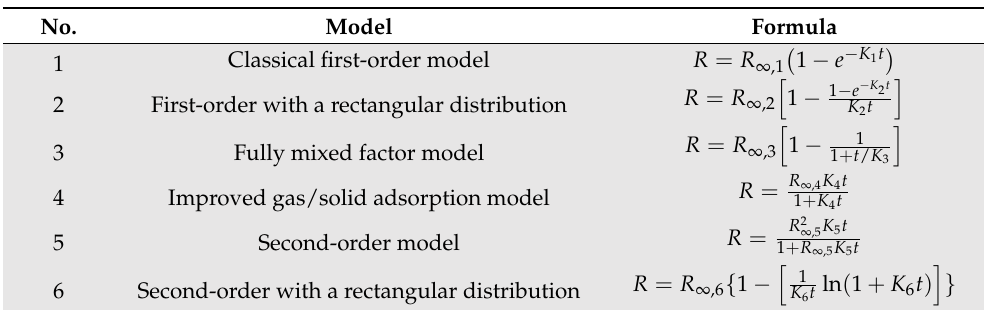
Table 2. Flotation kinetic models and formulas.